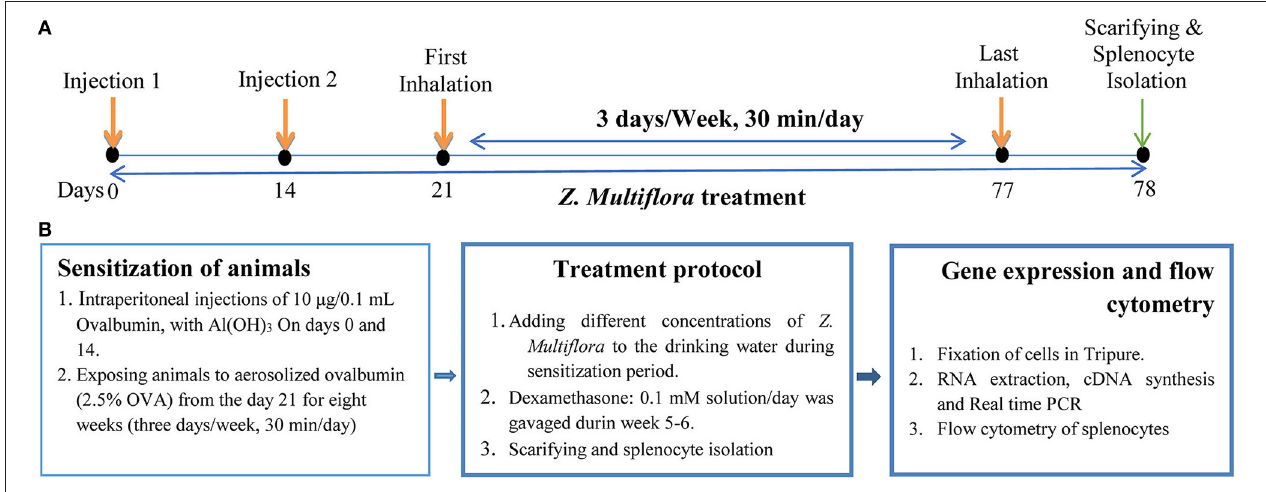
FIGURE 1 | The schematic time-course of inducing animal model of asthma, treatment, spleocyte isolation, flow cytometry and gene expression. (A) Induction of experimental animal model of asthma (sensitization) in mice. In control animals saline was administrated instead of OVA. (B) Treatment of animals with dexamethasone and three concentrations of Z. multiflora . In control and sensitized groups: animals were given drinking water alone. In group D: dexamethasone (0.1 mmol) was gavaged from the beginning of week 5 for 1 week. In groups Z1, Z2, and Z3: animals were given drinking water containing extract of Z. multiflora at three concentrations of 200, 400, and 800 µ